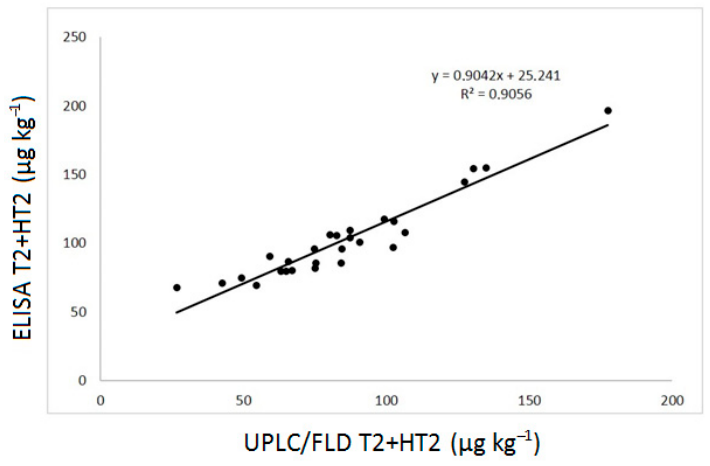
Figure 3. Correlation between results obtained by analyzing 27 samples using the ELISA and